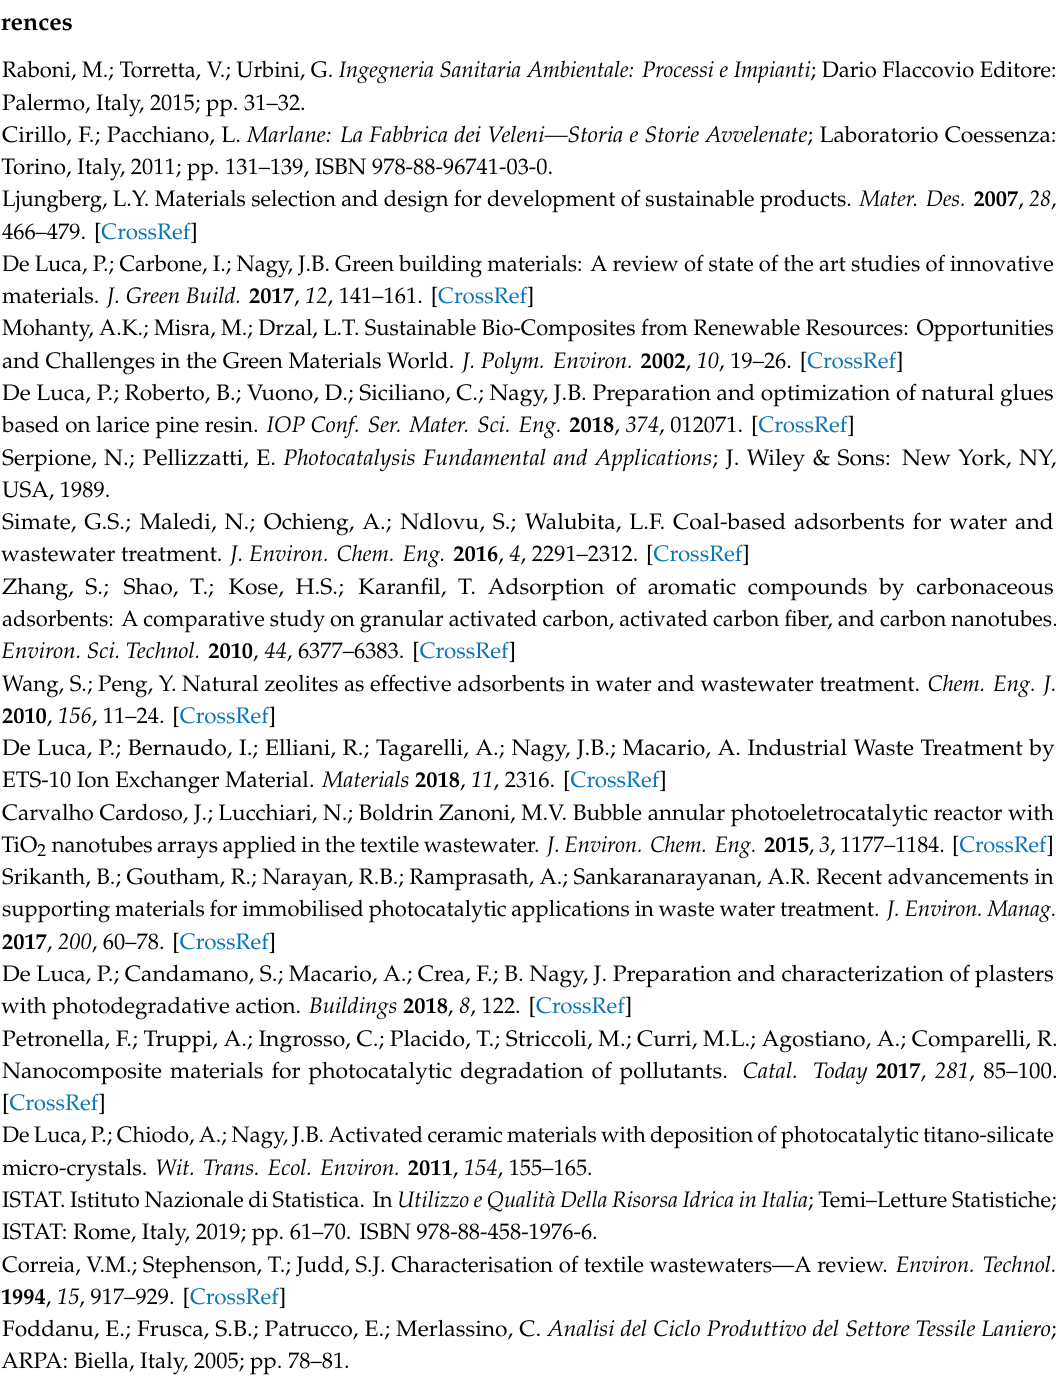
related on the pH. Figure S2. (a) RY-81 pKa protonation mechanism; (b) Formation and distribution diagram of the RY-81 complex